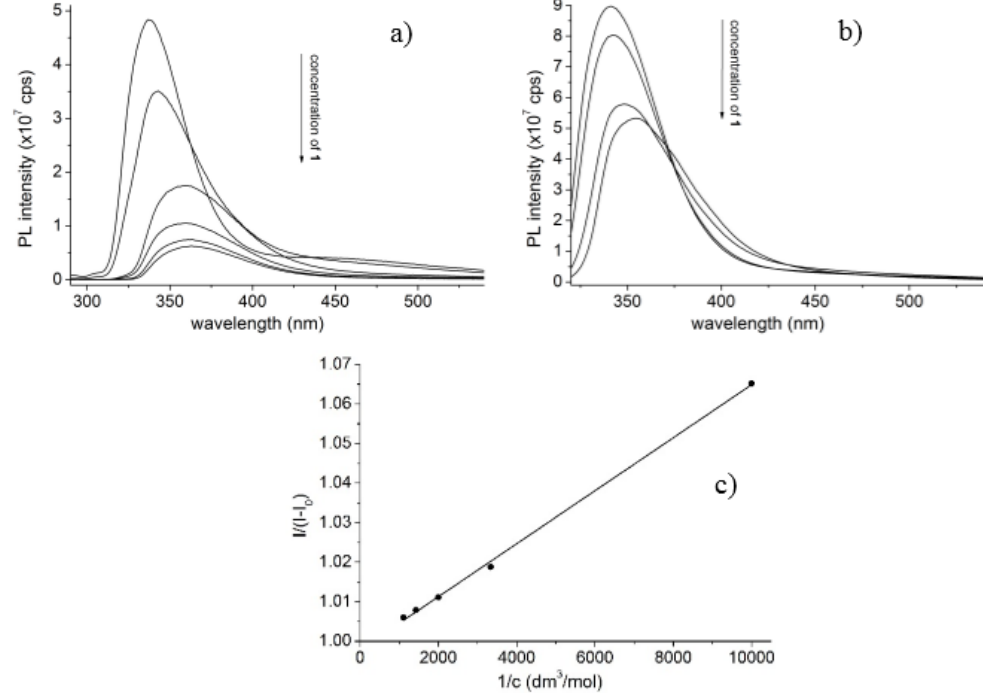
Figure 2. Emission spectra of 6 (100 μ M) in the absence and in the presence with increasing concentration of 1 (0–900 µ M) in ( a ) MeOH ( λ exc = 280 nm) or ( b ) DMF ( λ exc = 310 nm) solvents. ( c ) Representative Benesi–Hildebrand plot of the PL data to determine the stability constants (10 − 4 M of 6 upon increasing the concentration of 1 from 1.0 × 10 − 4 to 9.0 × 10 − 4 M).